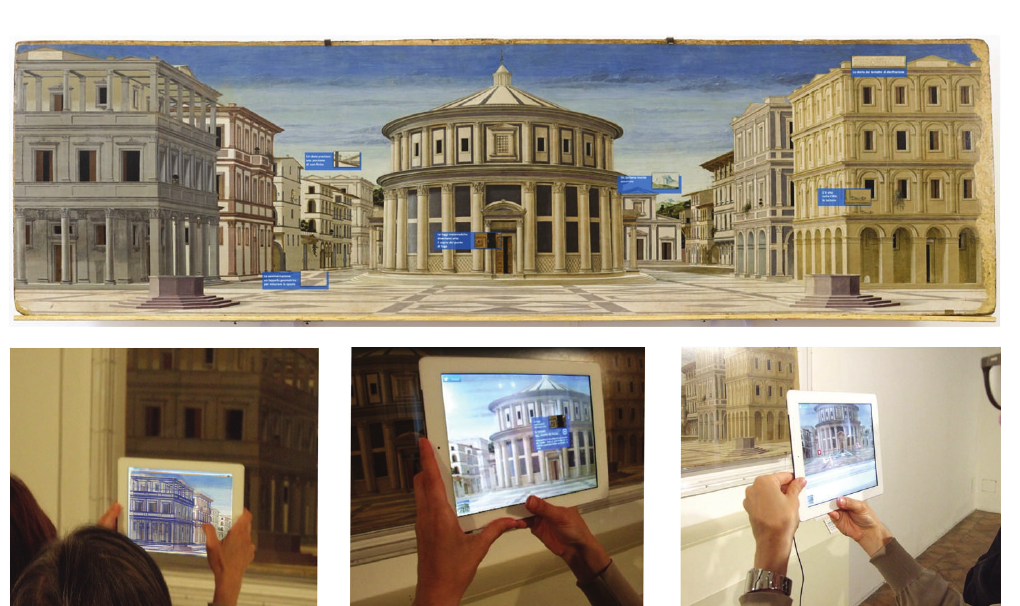
Figure 7: Image and text based point of interest in the AR application. In particular we tested image-based contents, videos (with transparent background), and shapes with text and interactive buttons to cope with social network activities and share contents from the AR